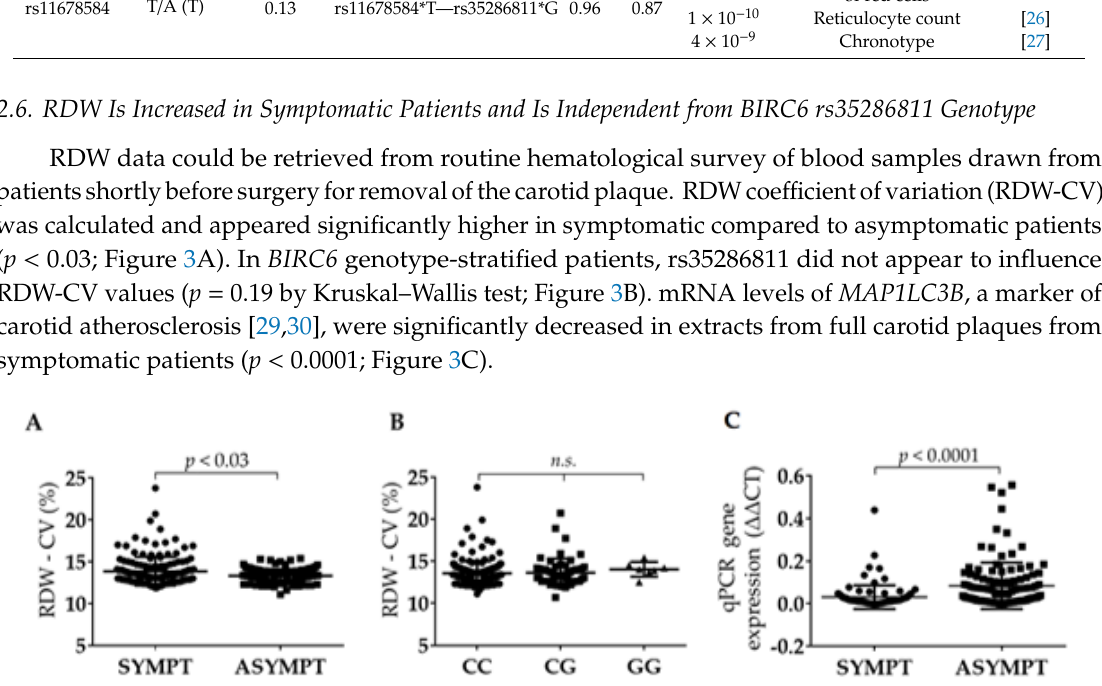
Figure 3. RDW-CV values in ( A ) symptomatic and asymptomatic patients, and ( B ) following stratification for rs35286811 genotype (n = 285). ( C ) MAP1LC3B gene expression levels by qPCR normalized for GAPDH and β -actin levels in extracts of carotid plaques from 70 asymptomatic and 104 symptomatic